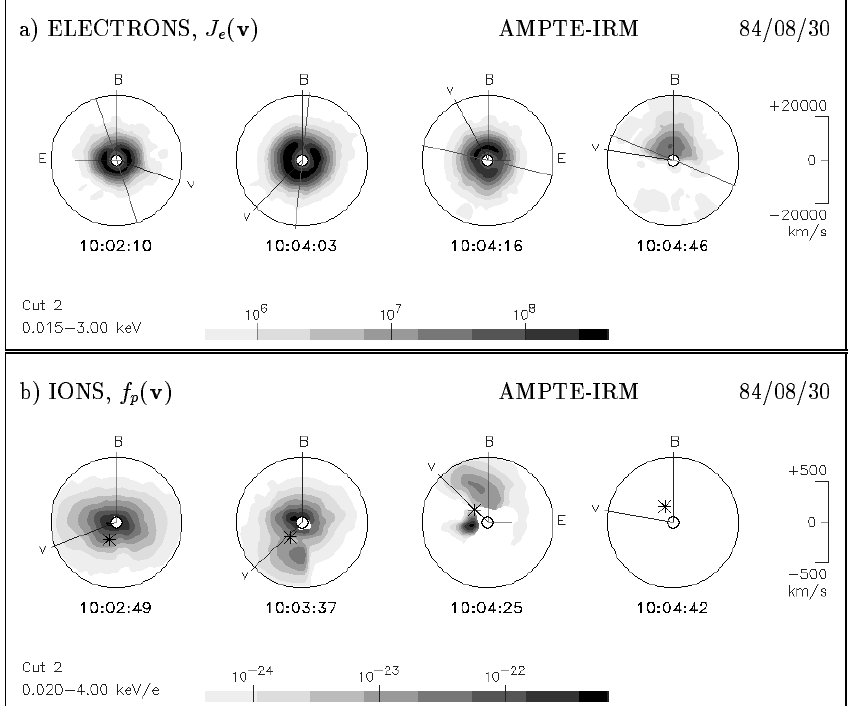
Fig. 5. Ion distributions in the energy range of 20eV–4keV and electron dis- tributions in the range of 15eV–3keV measured on 30 August 1984. The for- mat is the same as in Fig.